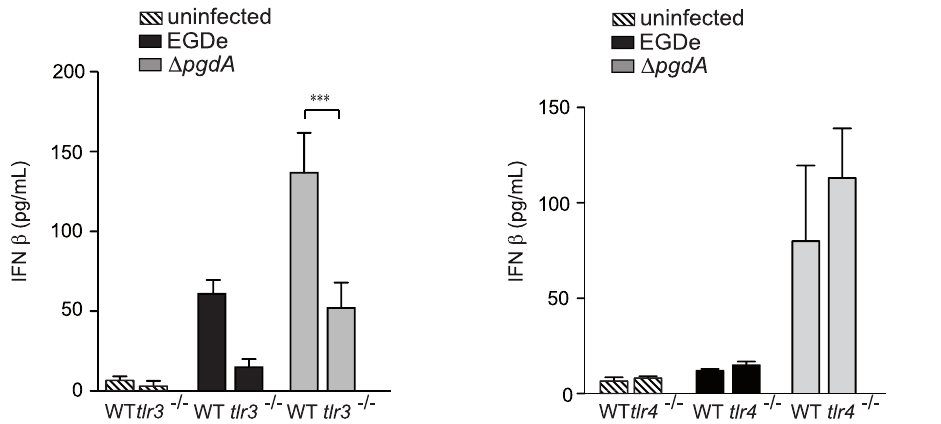
Figure 4. TLR3, but not TLR4, contributes to IFN- b response to Listeria in peritoneal macrophages. (A) PEM from WT C57BL/6J or tlr3 2 / 2 mice were infected with the parental EGDe strain (black bars), the D pgdA mutant (grey bars). After 7 h of infection, IFN- b levels were measured in supernatants by ELISA. Data are mean 6 SD (n=3). (B) PEM from WT C57BL/6J or tlr4 2 / 2 mice were infected with the parental EGDe strain (black bars), or the D pgdA mutant (grey bars). After 7 h of infection, IFN- b levels were measured in supernatants by ELISA. Data are mean 6 SD (***, p , 0.0001; n =3).